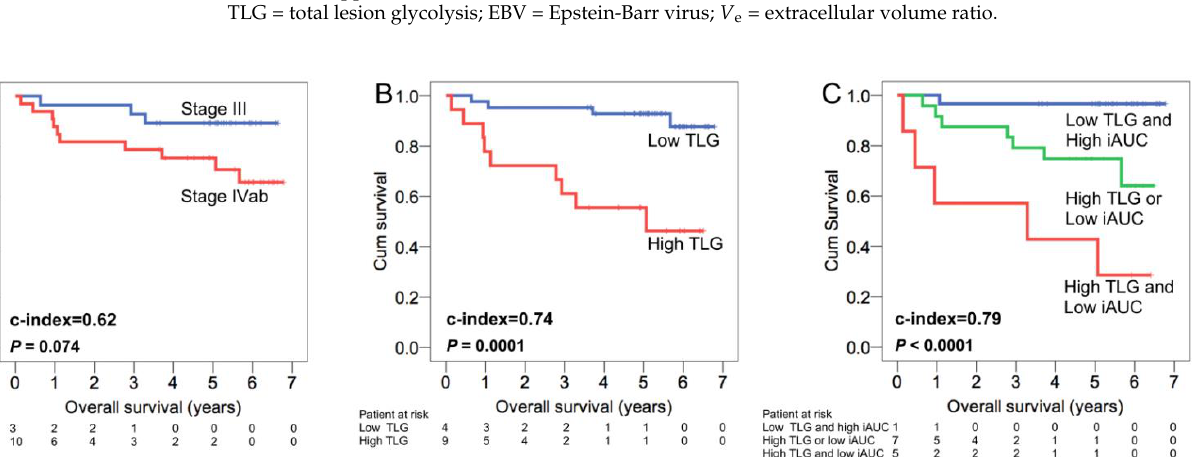
Table 5. Harrell’s concordance indices of the prognostic models and TNM stage in the training cohort and bootstrapping validation.